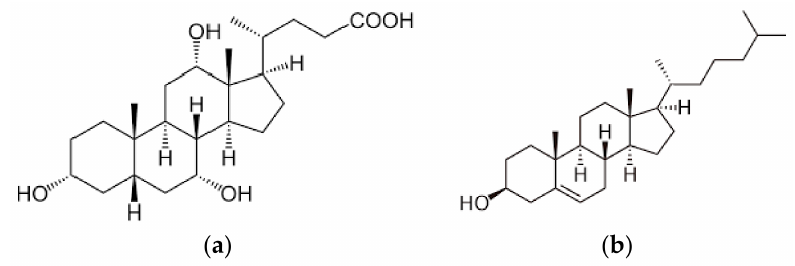
Figure 2. Structural formula of cholic acid ( a ) and cholesterol ( b